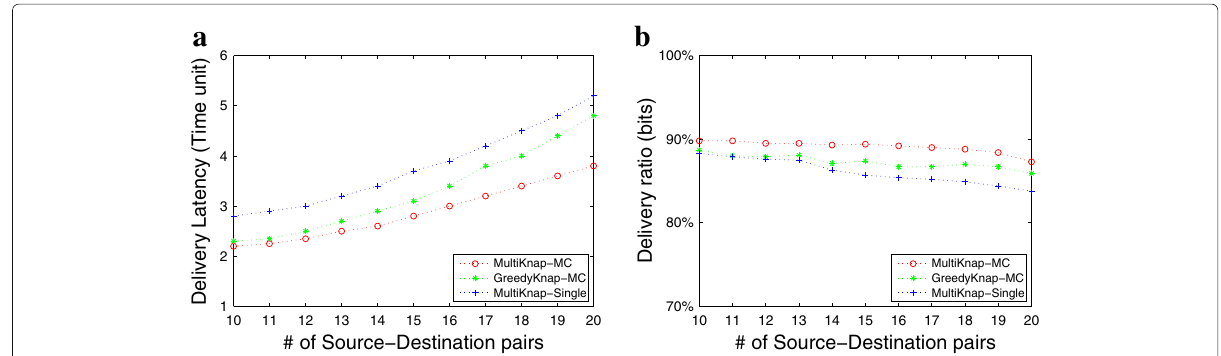
Fig. 5 Results of different number of source-destination pairs. a Delivery delay. b Delivery